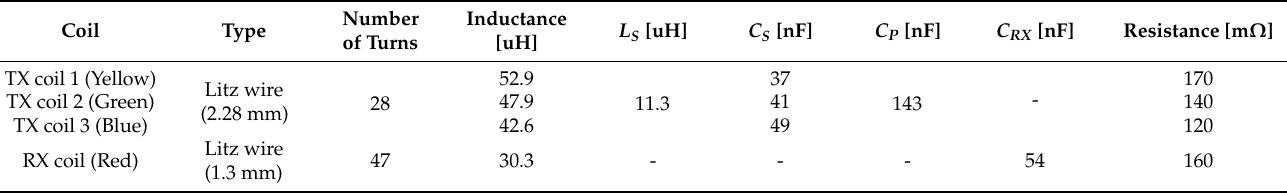
Table 6. Value of parameters of the proposed